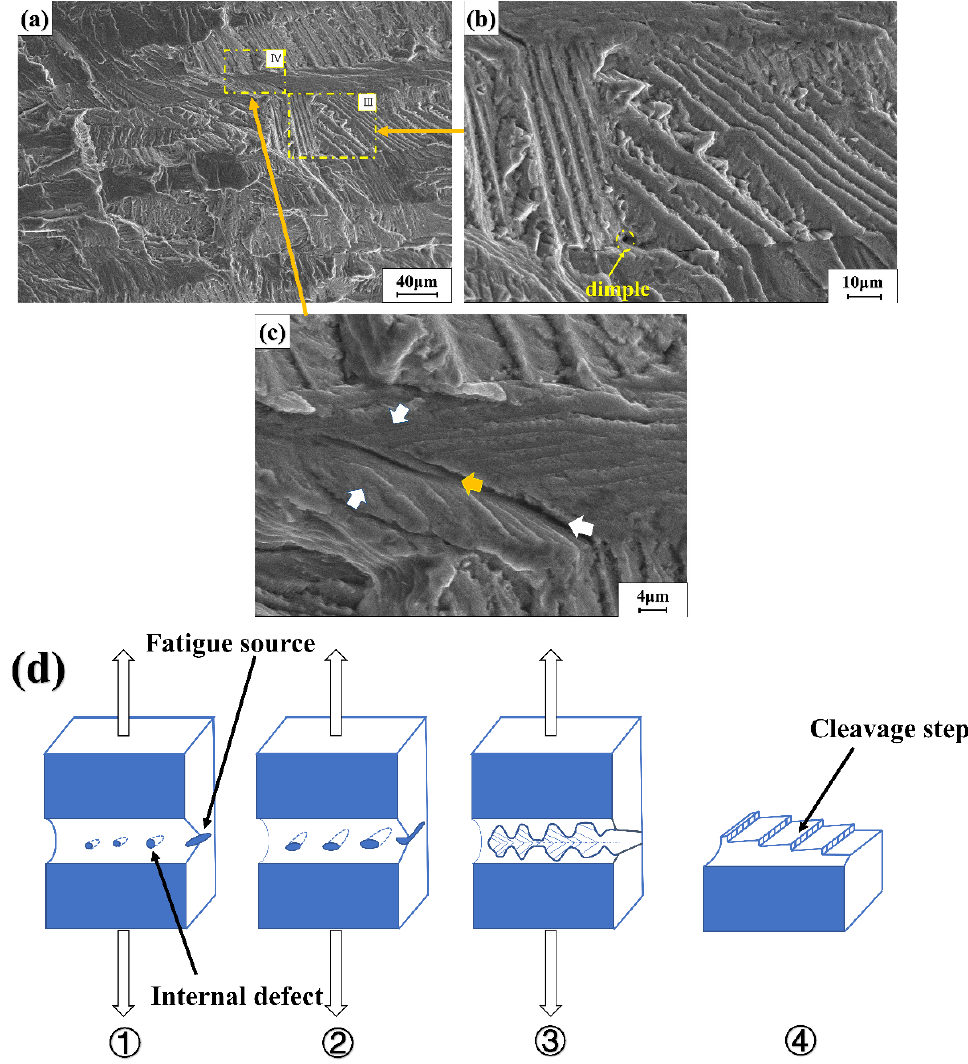
Figure 8. ( a ) The microscopic morphology of the crack propagation zone; ( b ) the partial enlarged view of ( a ) III; ( c ) the partial enlarged view of ( a ) IV; ( d ) evolution model